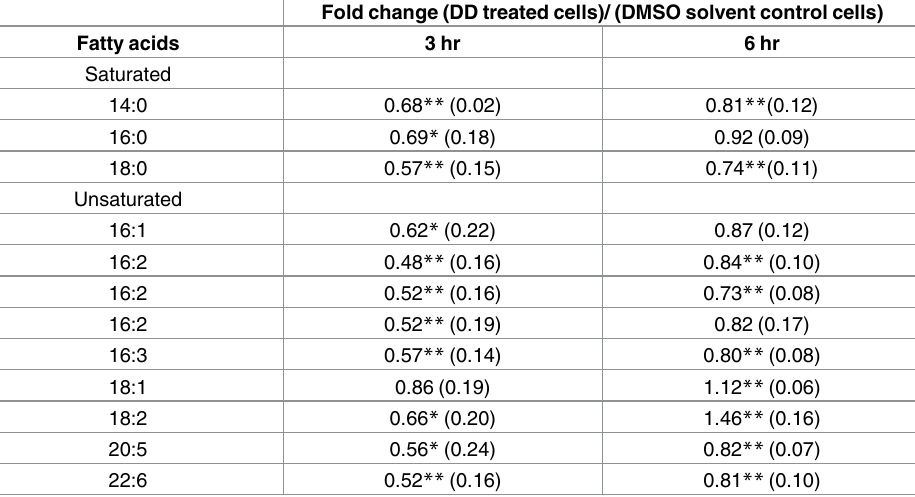
Table 1. Fold changes in saturated and unsaturated fatty acids in 10 µ M DD treated cells compared to DMSO solvent control at 3 hr and 6 hr. Data presented for 3 hr time point is representative of two indepen- dent experiments; 5–8 biologicalreplicates each for DMSO and DD treatments. Data for 6 hr time point is rep- resentative of three independent experiments; 5–8 biological reps each for DMSO and DD treatments; numbers in brackets indicate ± SD; Significance * p < = 0.1 and ** p < 0.05calculatedby student’s t-test in com- parison to the